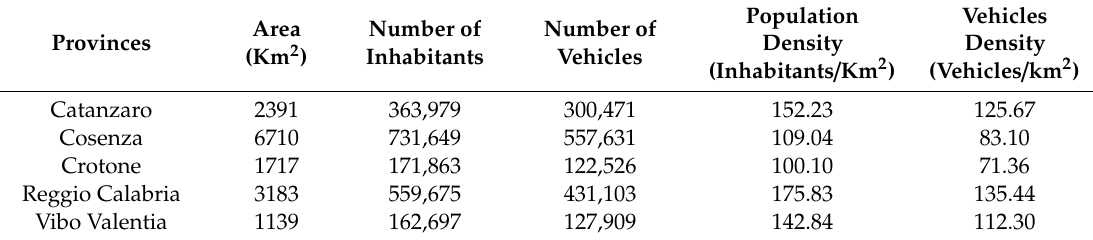
Table 1. Characteristics of the five Calabrian provinces referring to the year 2015.